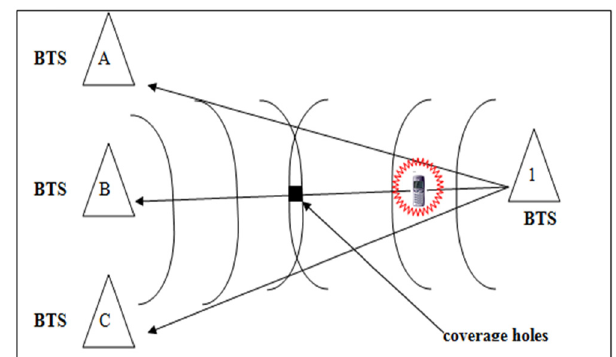
Figure 3: Illustration of the case study.